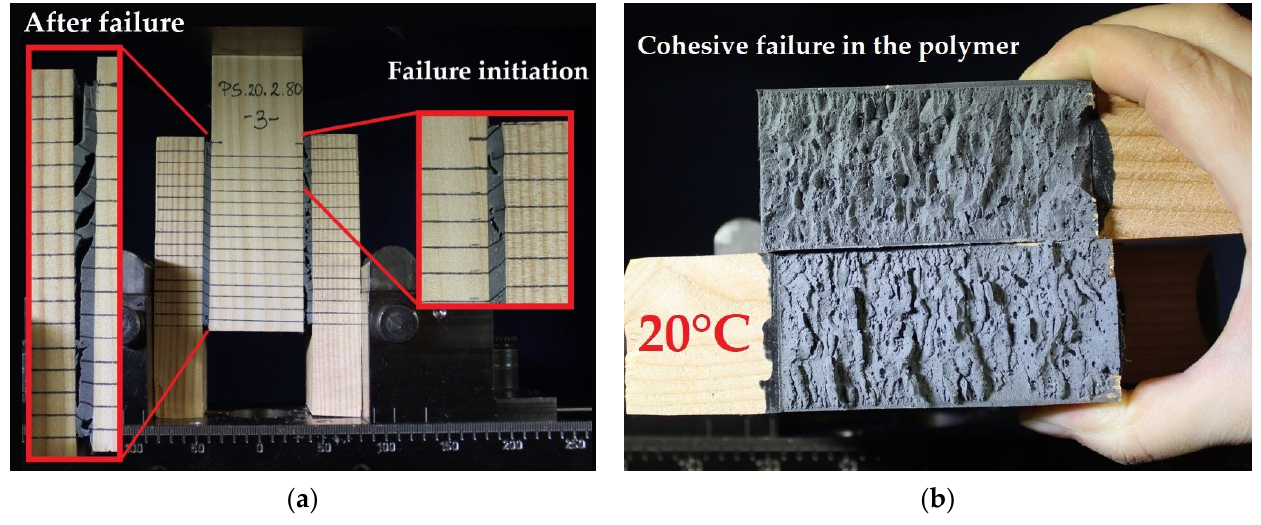
Figure 9. Reference specimen: ( a ) failure initiation and the joint after failure; ( b ) joint cross section—cohesive failure in polymer.